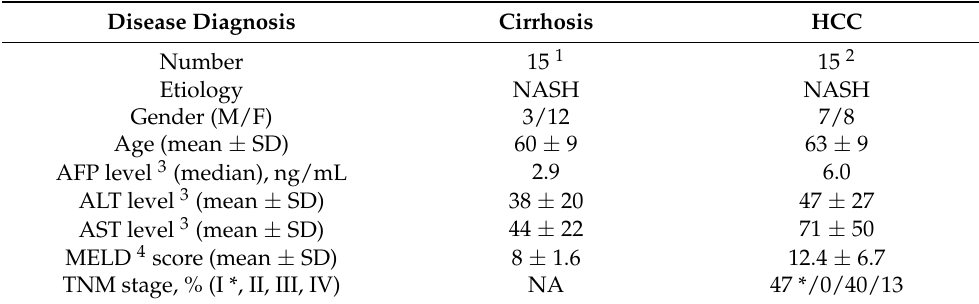
Table 3. Summary of patient clinical information. Disease